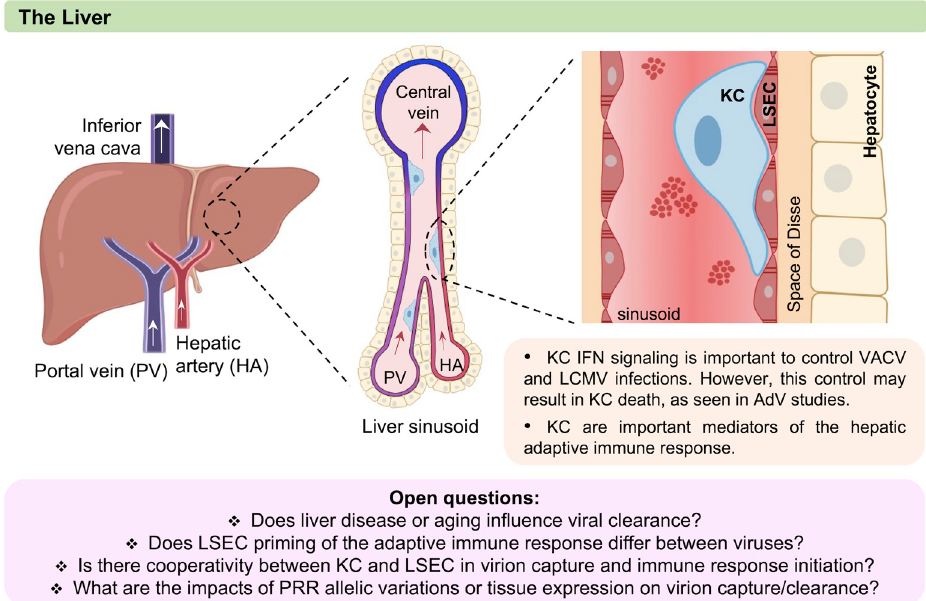
Fig 1. The liver sinusoid. There are 2 key cell types located in the liver sinusoid that have been shown to contribute to viral vascular clearance. Although in vitro studies suggest that LSECs, which form the liver endothelium, interact with certain viruses (e.g., AdV), KCs, which are the liver’s main tissue-resident macrophages, are responsible for clearing diverse circulating viruses (e.g., CHIKV and AdV) in vivo. In addition, KCs are important in controlling pathogenesis of viruses like LCMV. This figure was created with BioRender.com. A AU : AbbreviationlistshavebeencompiledforthoseusedinFigs 1 (cid:0) 3 : Pleaseverifythatallentriesarecorrect : dV, adenovirus; CHIKV, chikungunya virus; HA, hepatic artery; IFN, interferon; KC, Kupffer cell; LCMV, lymphocytic choriomeningitis virus; LSEC, liver sinusoidal endothelial cell; PRR, pathogen recognition receptor; PV, portal vein; VACV, vaccinia